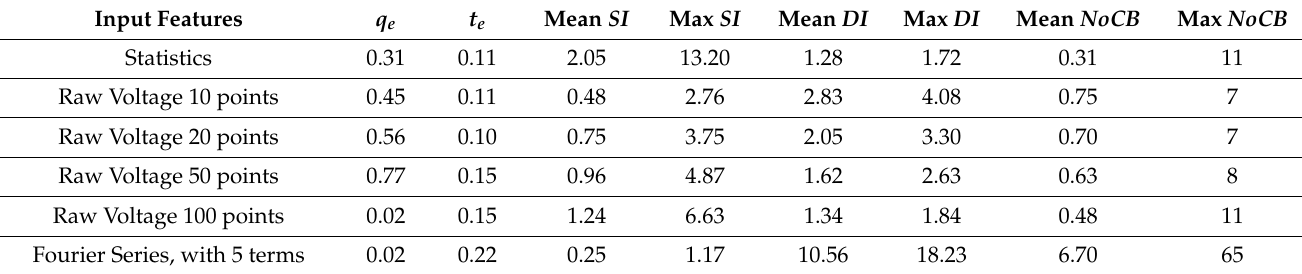
Table 3. Metrics for 10 × 18 SOMs trained with input data obtained by using different feature extraction techniques. Input